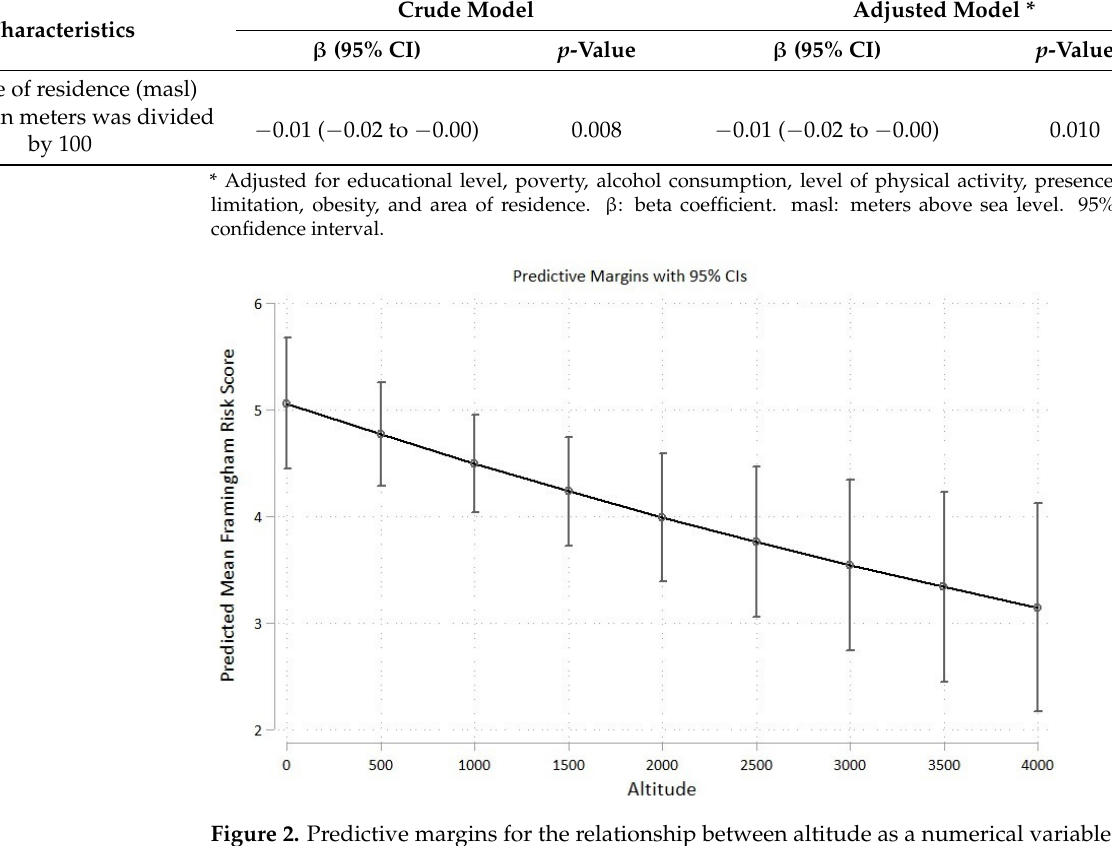
Figure 2. Predictive margins for the relationship between altitude as a numerical variable and the Framingham risk